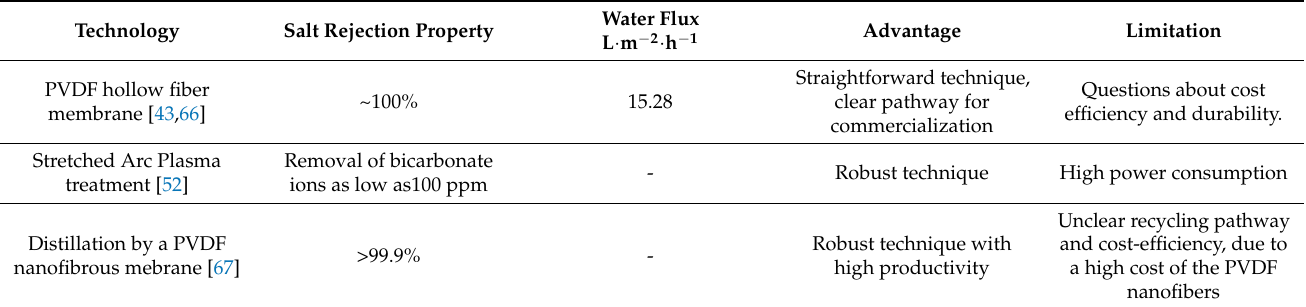
Table 2. Summary of the desalination